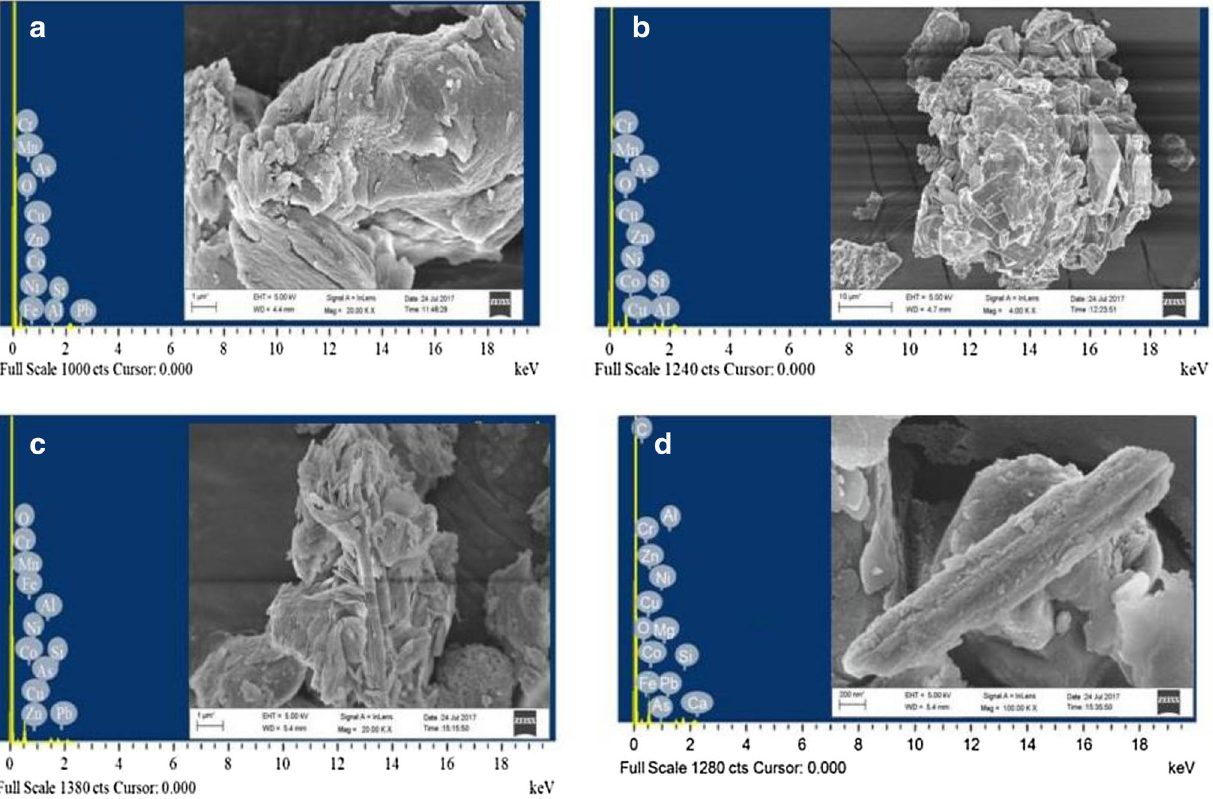
Fig. 35 FESEM-EDS micrographs of raw coal samples LC-20A ( a ), LC-60A ( b ) and OB samples LOB-15A ( c ), LOB-15B ( d